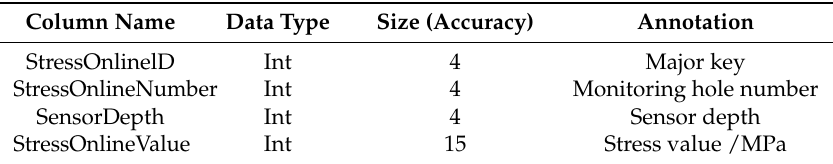
Table 9. Stress online dimension table properties.